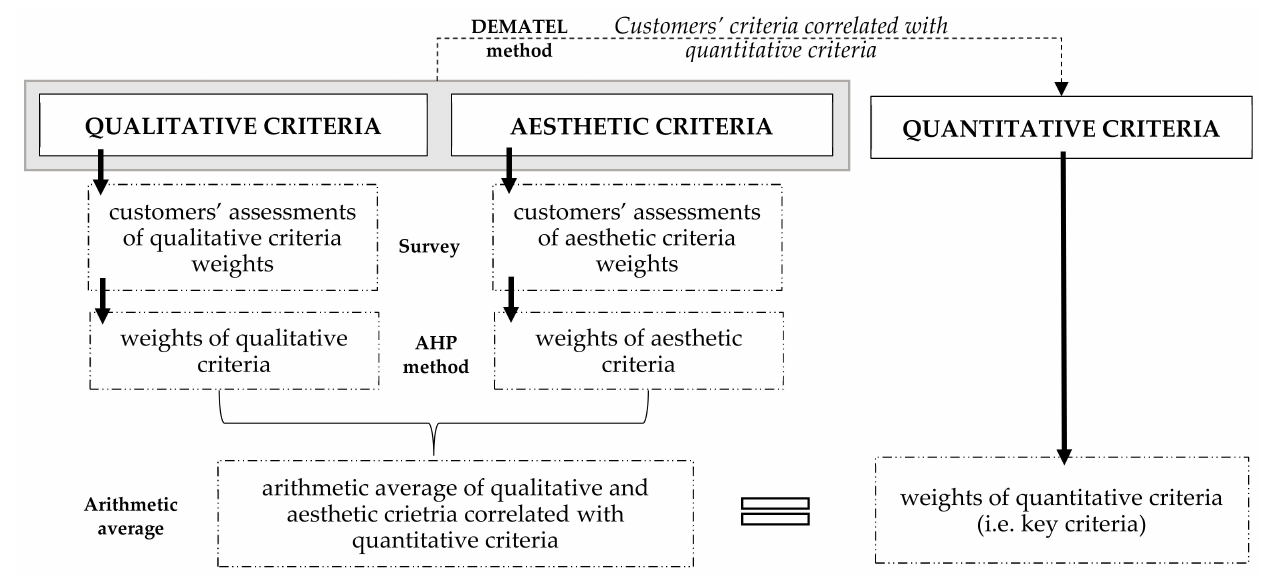
Figure 7. Relations between PV criteria and way to calculate its weights. Own